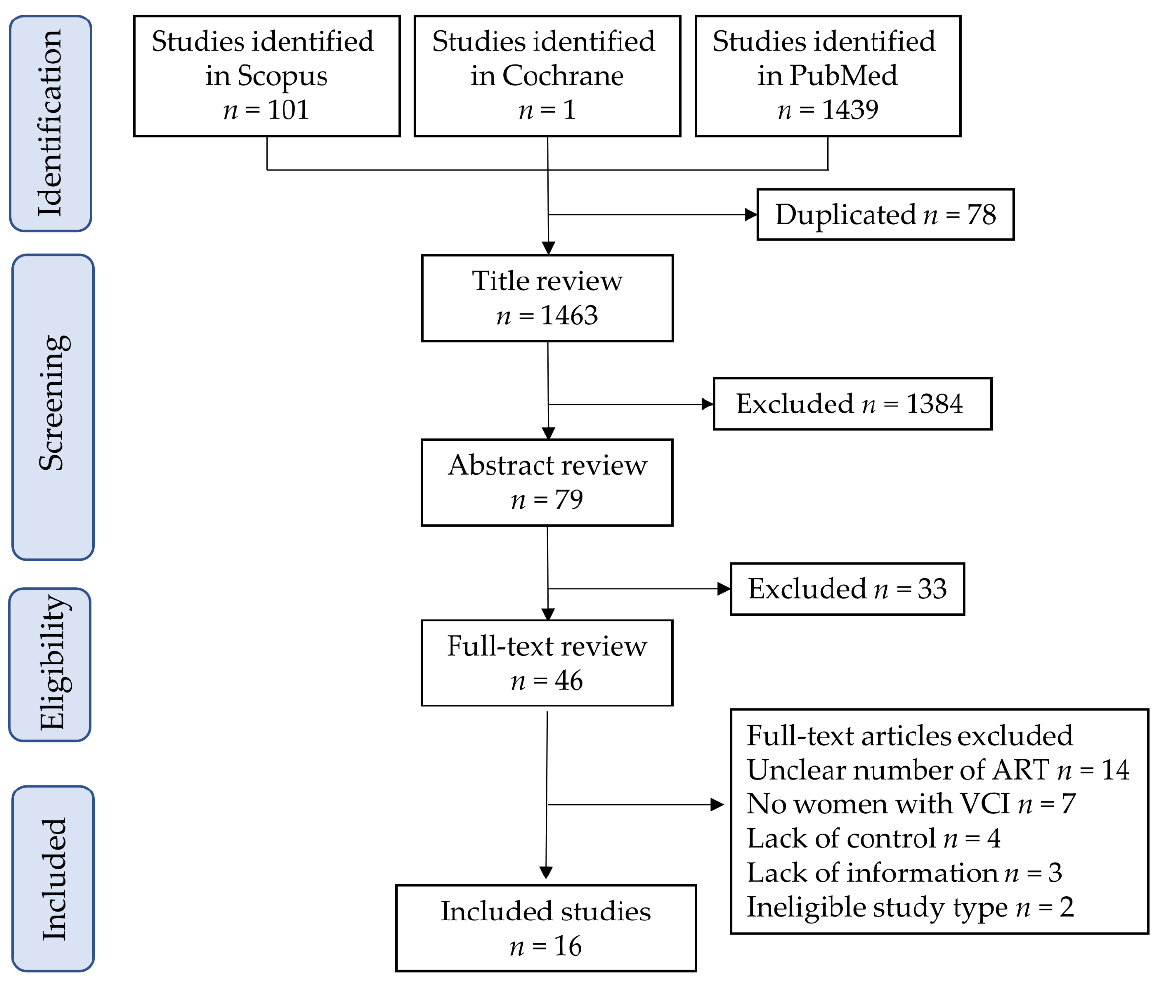
Figure 1. Study selection scheme of the systematic literature search. Abbreviations: ART, assisted reproductive technology; and VCI, velamentous cord insertion.